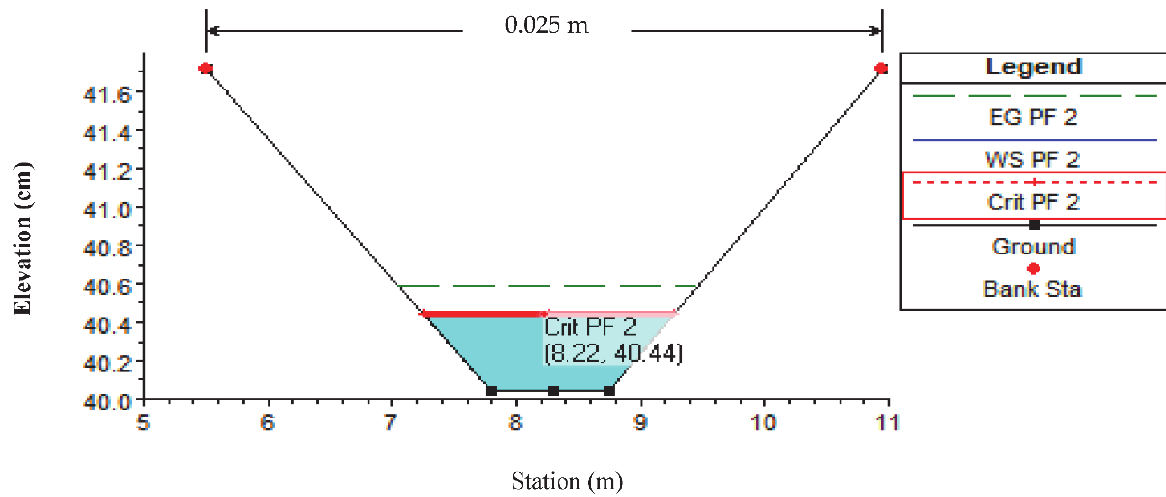
Figure 9. River cross ‐ section downstream with planned discharge.